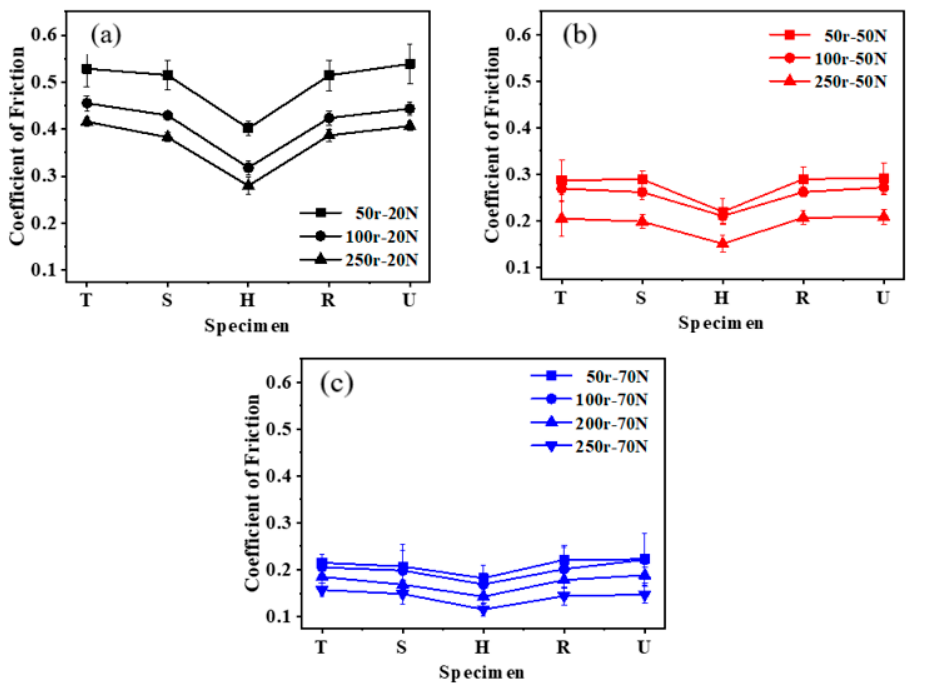
Figure 6. The average friction coefficients of four cross-grooved texture shapes under the loads of ( a ) 20 N, ( b ) 50 N, and ( c ) 70